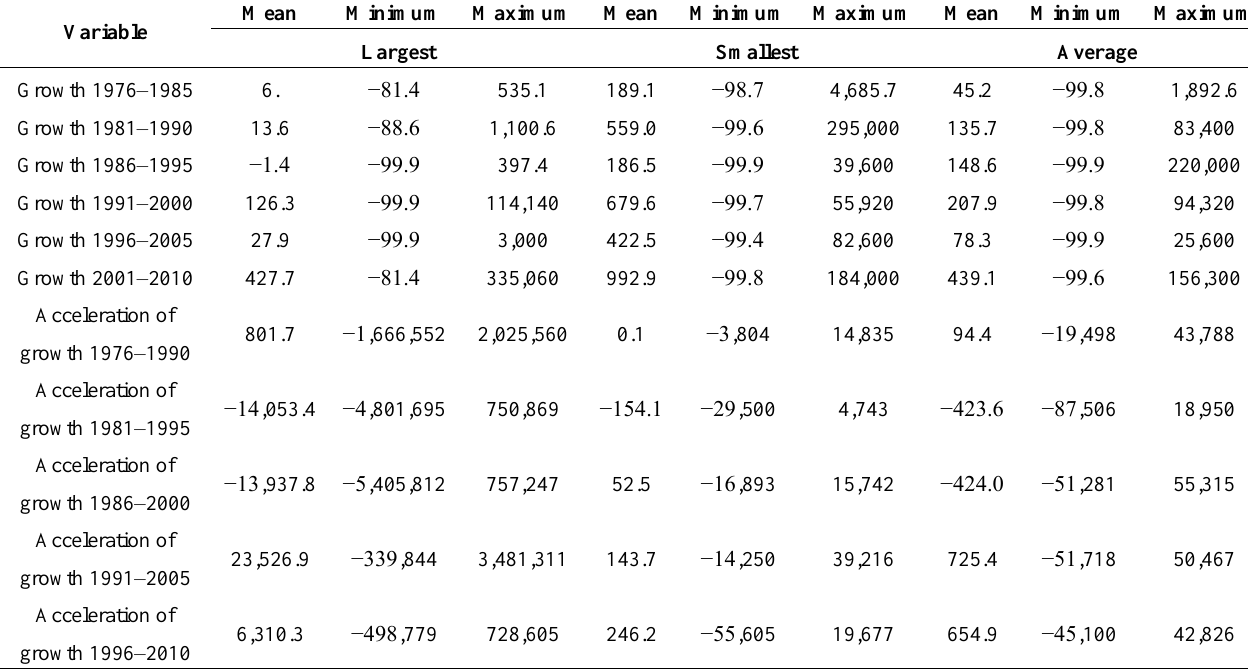
Table 2. Growth and production averages for municiplaities producing sheep in Brazil.